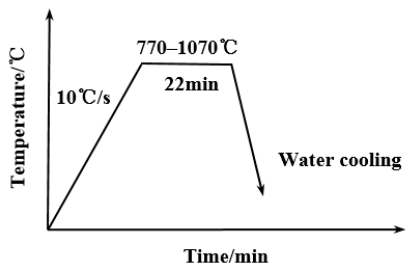
Figure 1. Heat treatment process. (2) Determination of critical